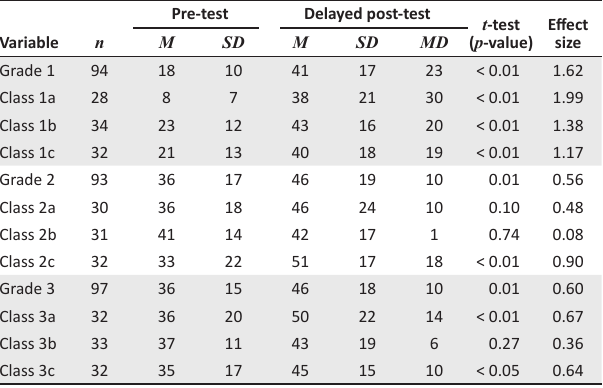
TABLE 2: Pre-test and delayed post-test means and standard deviations for multiplicative reasoning items at grade and class levels (matched learners) (percent). Variable n